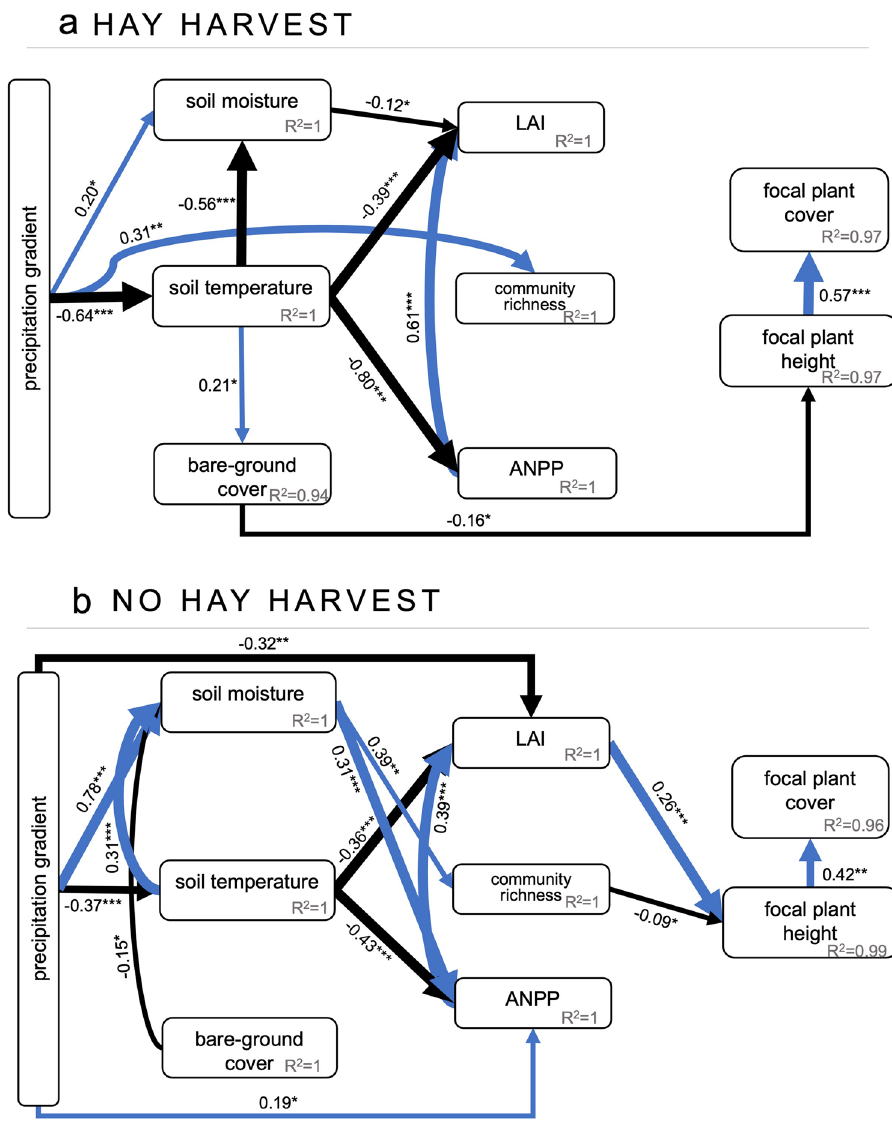
Figure 1. Piecewise Structural Equation Models (SEMs) describing the relationships among plant performance (focal plant cover, focal plant height), biotic variables (LAI—leaf area index, ANPP—aboveground net primary productivity, community richness), abiotic variables (soil moisture, soil temperature, bare-ground cover) in plots with hay harvest ( a ) no hay harvest ( b ) across precipitation treatments. Conditional R 2 values (i.e., including fixed and random effects) are under each predicted variable and standardized path estimates are provided next to each path with line thickness scaled based on the strength of the relationship (see “Methods” for variable descriptions): * P ≤ 0.05, ** P ≤ 0.01, *** P ≤ 0.001. Only significant relationships ( P ≤ 0.05) are shown. Blue and black arrows indicate positive and negative relationships, respectively. Arrow widths are proportional to the strength of the relationship. The proportion of variance explained (R 2 ) appears alongside the response variable in the model. Model estimates, standard errors, and P -values for significant and non-significant relationships are provided in Supplementary Tables